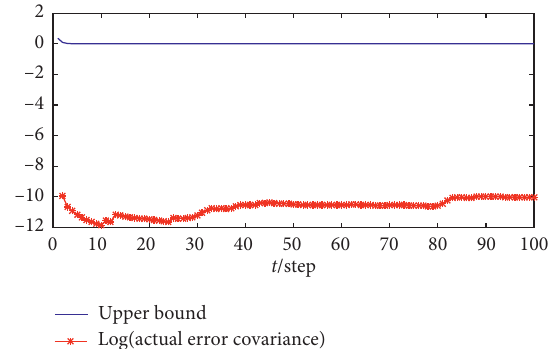
Figure 2: Actual state and its estimated state for the second state.